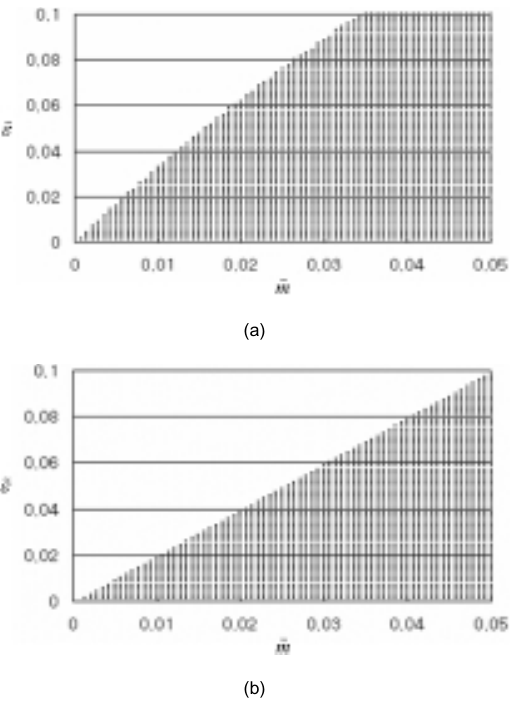
Fig. 4. Comparison of stability for the variation of ˜ m and ˜ ε . (a) Pendulum Automatic Dynamic Balancer. (b) Ball Automatic Dynamic Balancer.